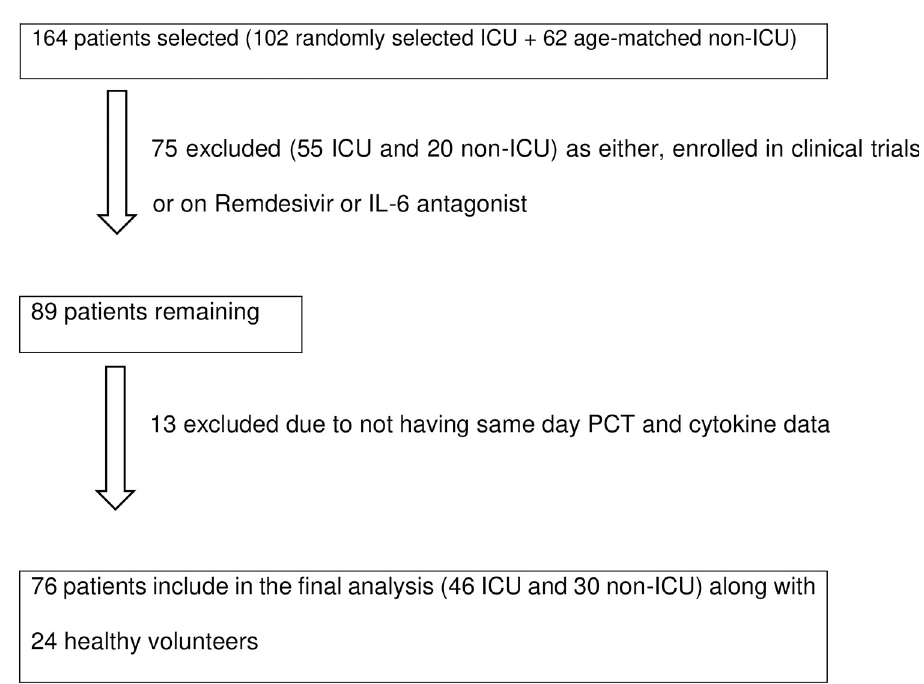
Fig 1. Flow chart of patient selection based on inclusion and exclusion